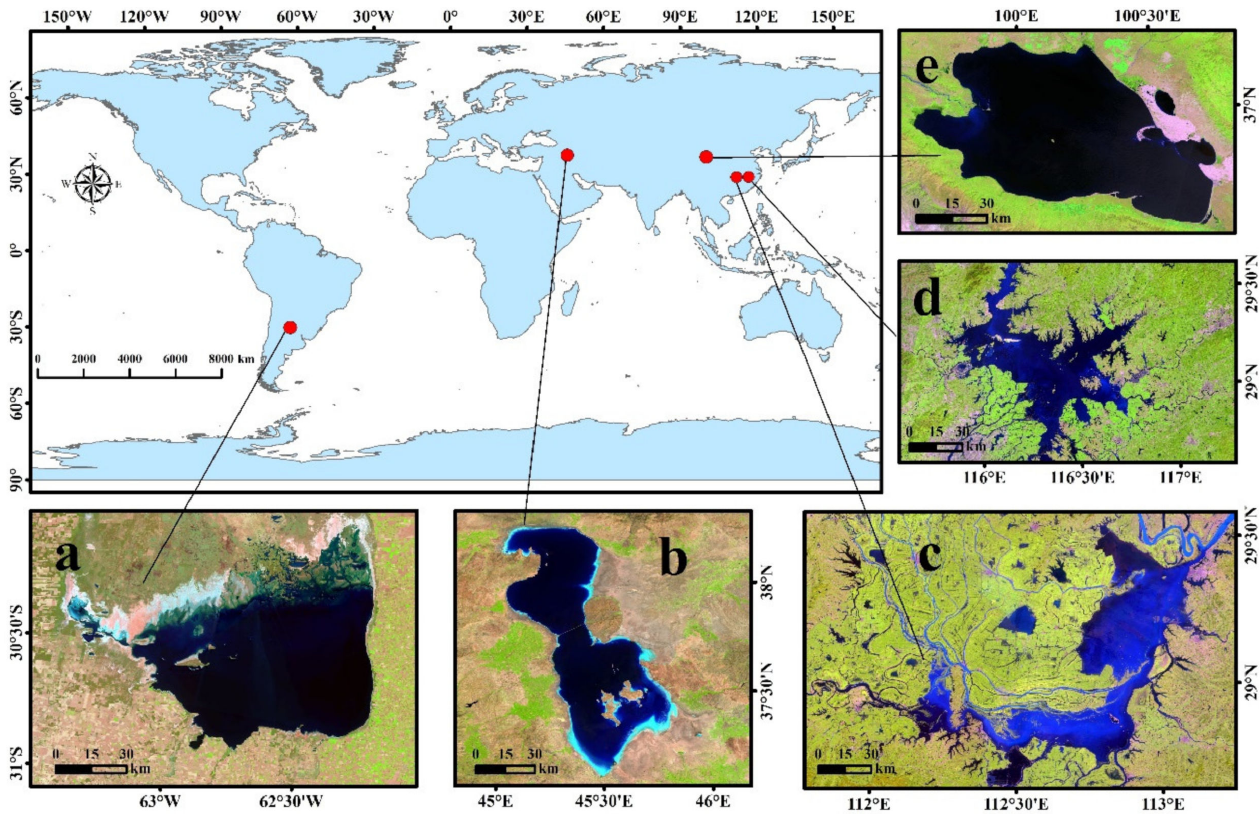
Figure 1. Locations and typical images of the case lakes for ( a ) Chiquita Lake, ( b ) Urmia Lake, ( c ) Dongting Lake, ( d ) Poyang Lake, and ( e ) Qinghai Lake. RGB channels were synthesized using ‘swir1’, ‘nir’, and ‘red’